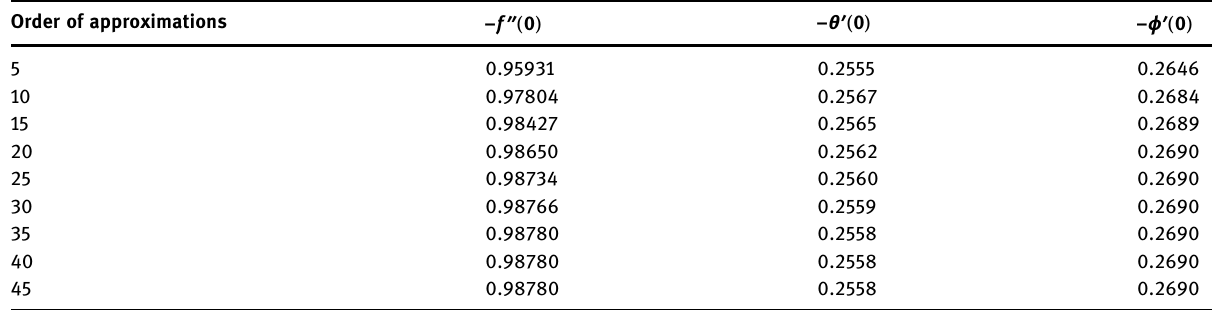
Table 1: Convergence of HAM series solution when A